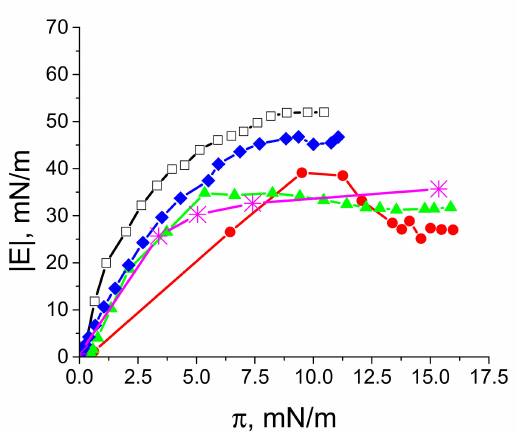
Figure 2. The dependences of the dynamic surface elasticity modulus on surface pressure of spread LYS layers on 0.1 M NaCl solution, pH 10 (open black squares), and for spread layers of a LYS microgel with different numbers of purification cycles: 0 (red circles), 1 (green triangles), 2 (blue diamonds), 3 (magenta snowflakes). The last curve was obtained by surface layer compression after